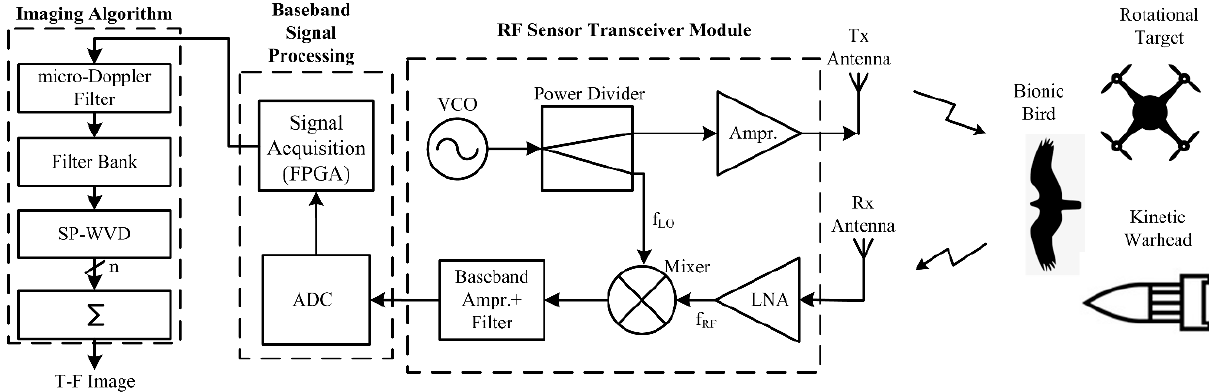
Figure 3. A schematic diagram illustrating the developed RF sensor.